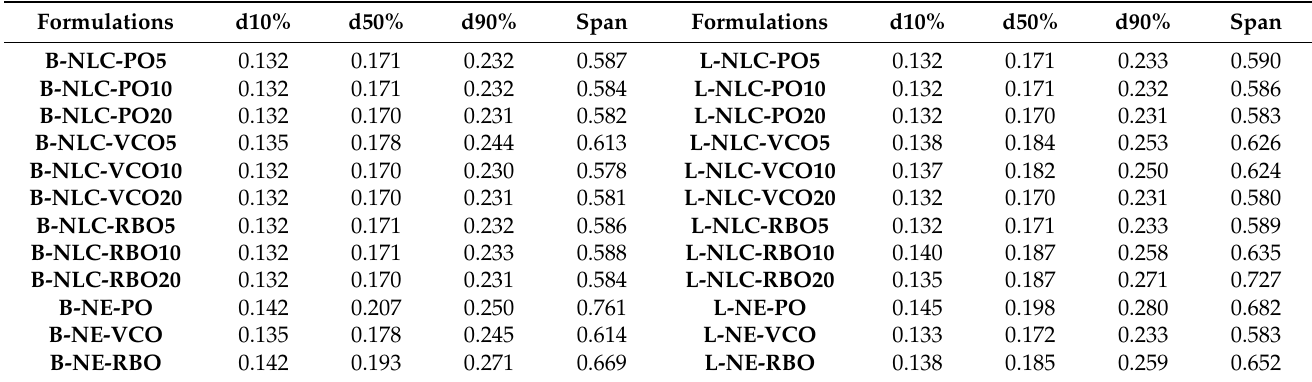
Table 2. Volume distribution diameters in micrometers (d10%, d50% and d90%) and Span values of